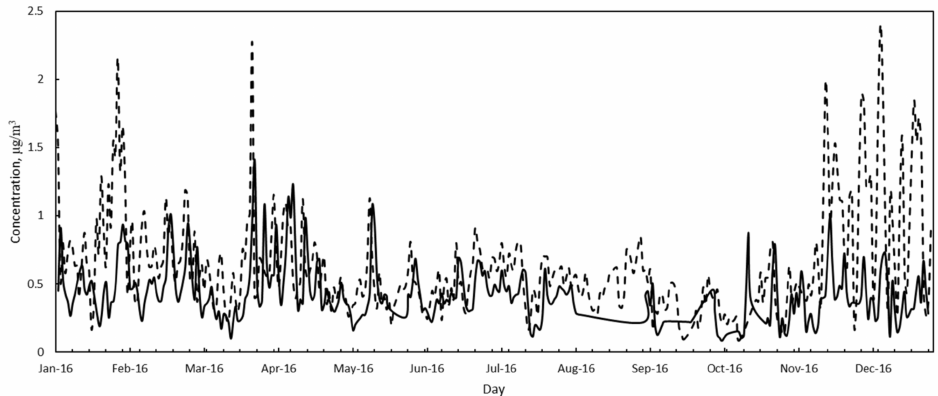
Figure 5. Arsenic daily average concentrations measured in the HI (dashed black line) and LI (solid black line) area during 2016 from the ARPAC network.